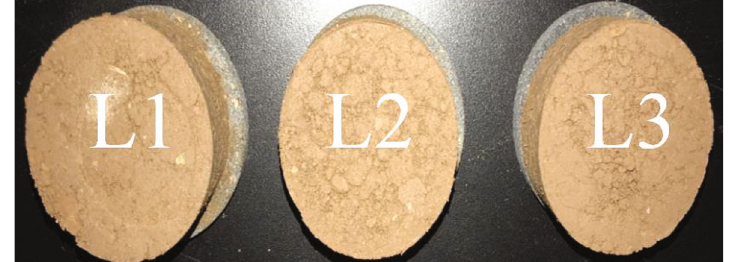
Figure 3: Sketch of test device.